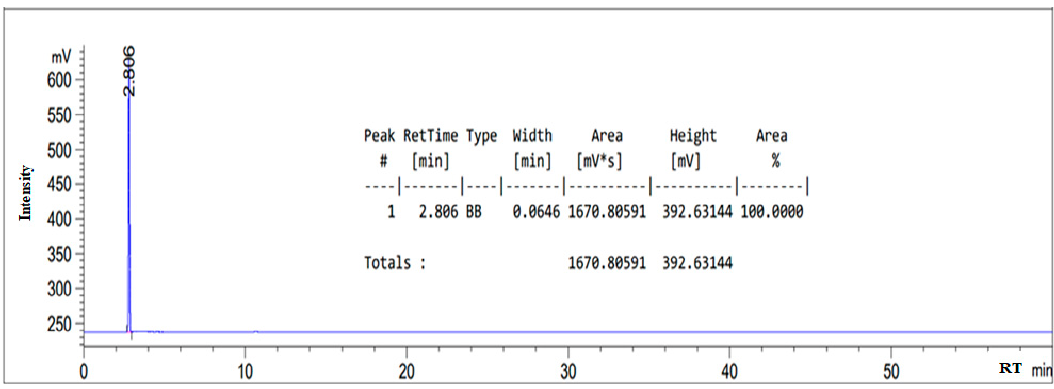
Figure A1. HPLC chromatogram for 0.5 wt.% Oleic acid.